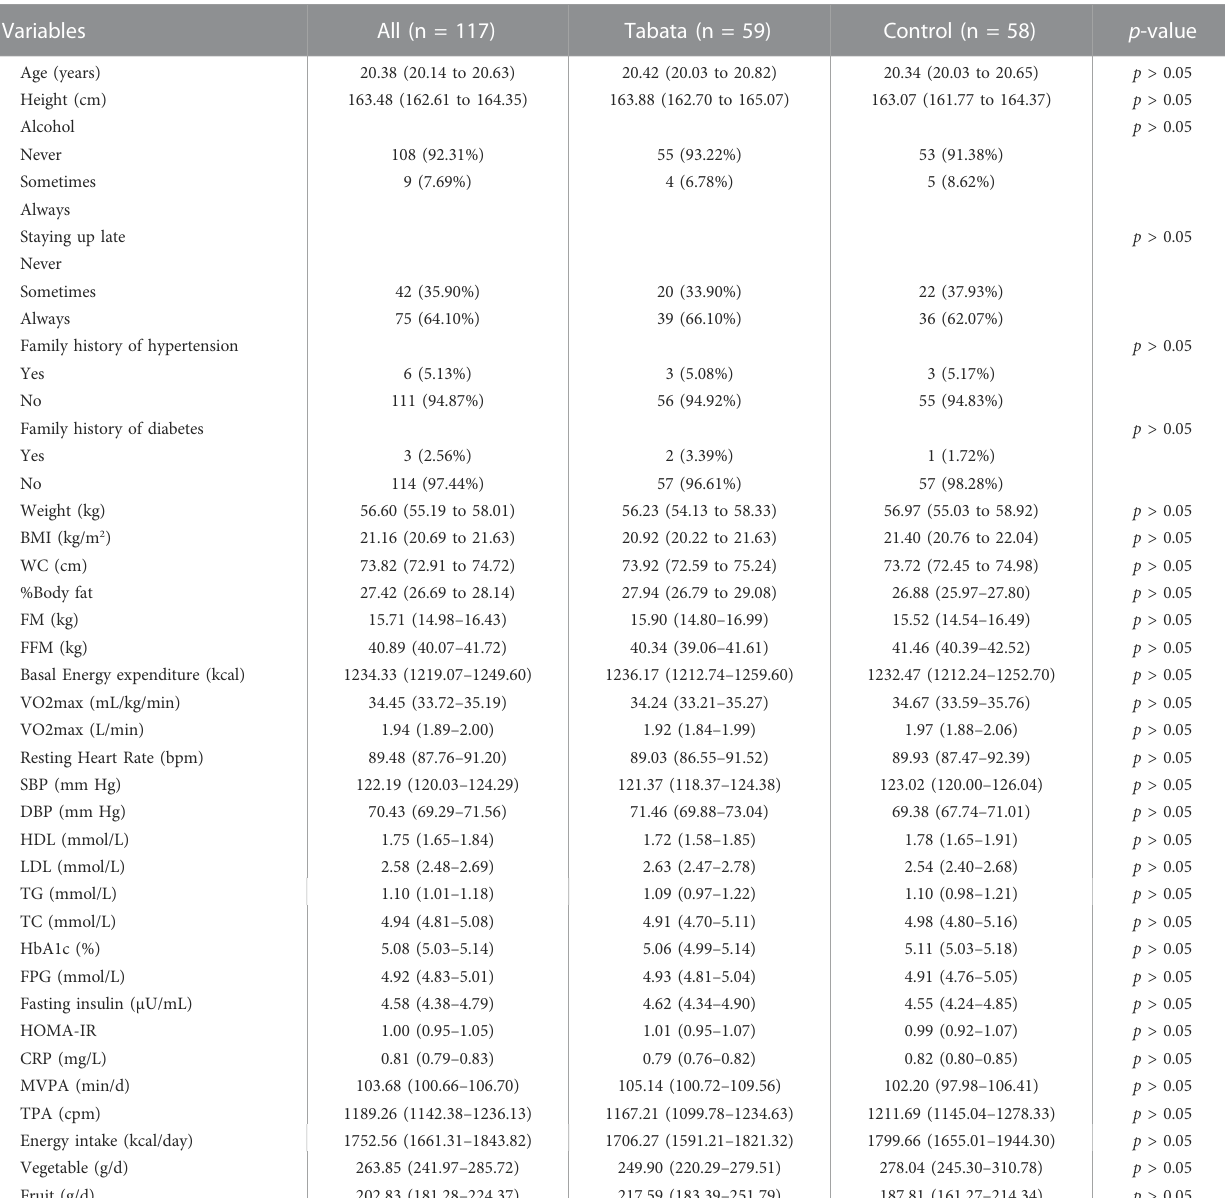
TABLE 1 Baseline characteristics of